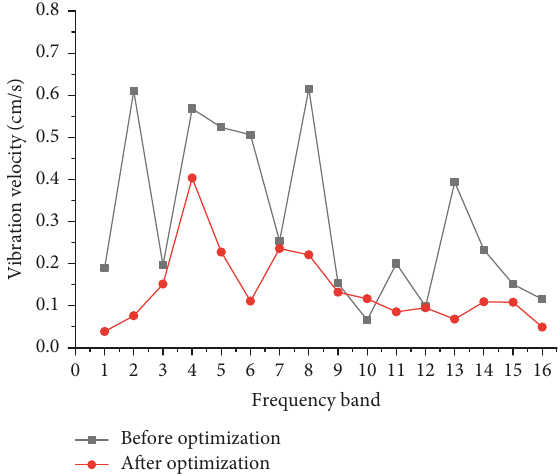
Figure 21: Vertical vibration velocity with frequency band distribution.